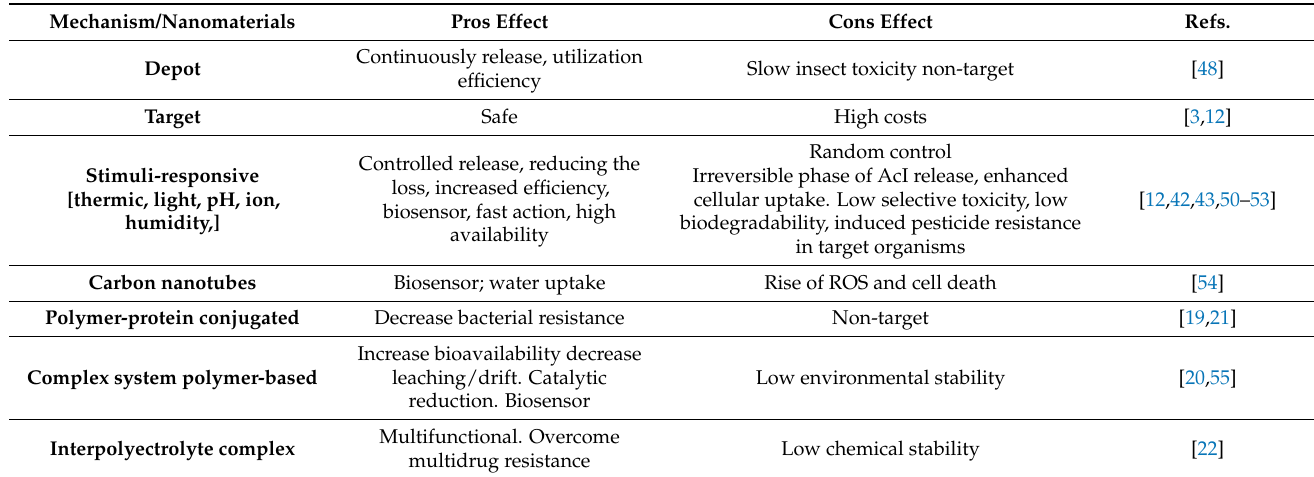
Table 2. Innovative nanomaterials for stimuli-responsive release.